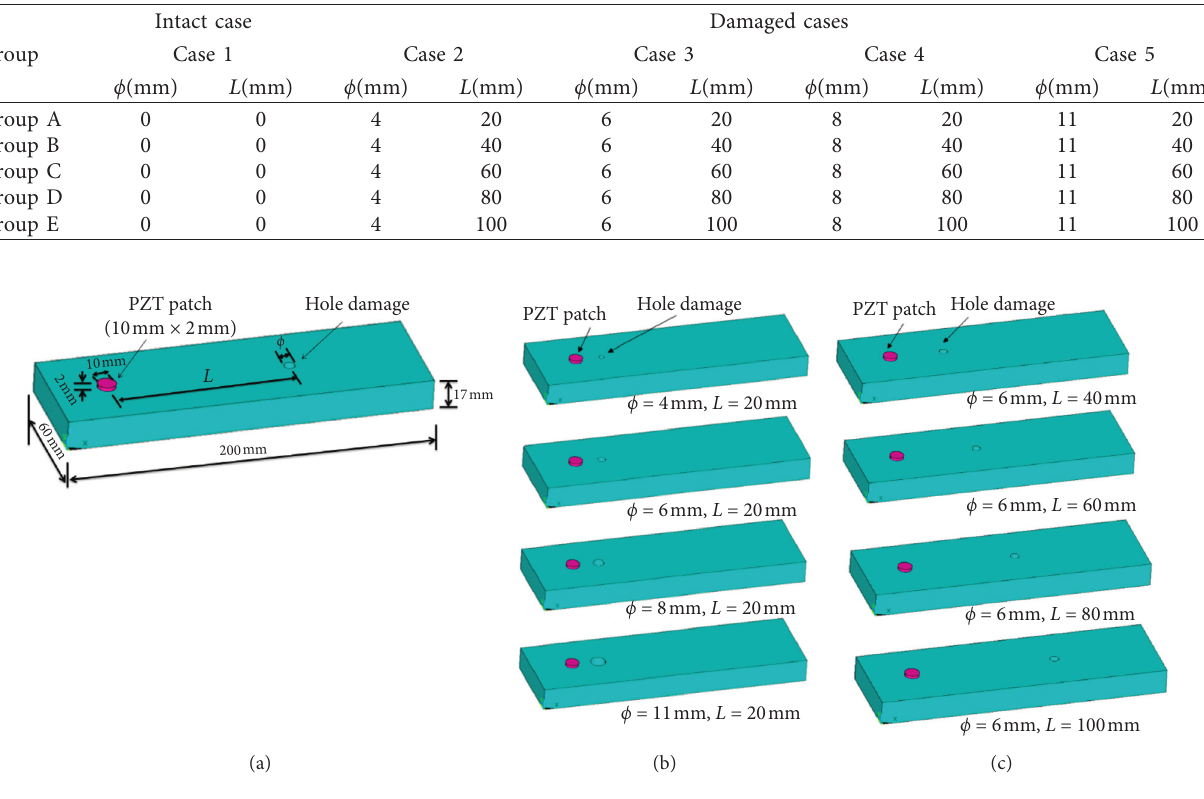
Figure 3: The schematic of different timber specimens with different damages. (a) The dimension of the timber specimen. (b) Holes with a fixed position and varied diameters. (c) Holes with a fixed diameter and varied locations.